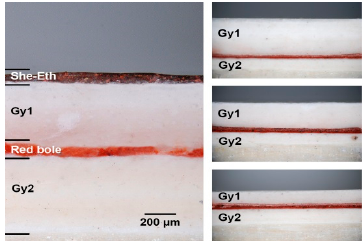
Figure 4. Cross-section microphotographs from (left) A7, (upper right) A5, (center right) B5, (lower right) C5 areas (see Figure 2).